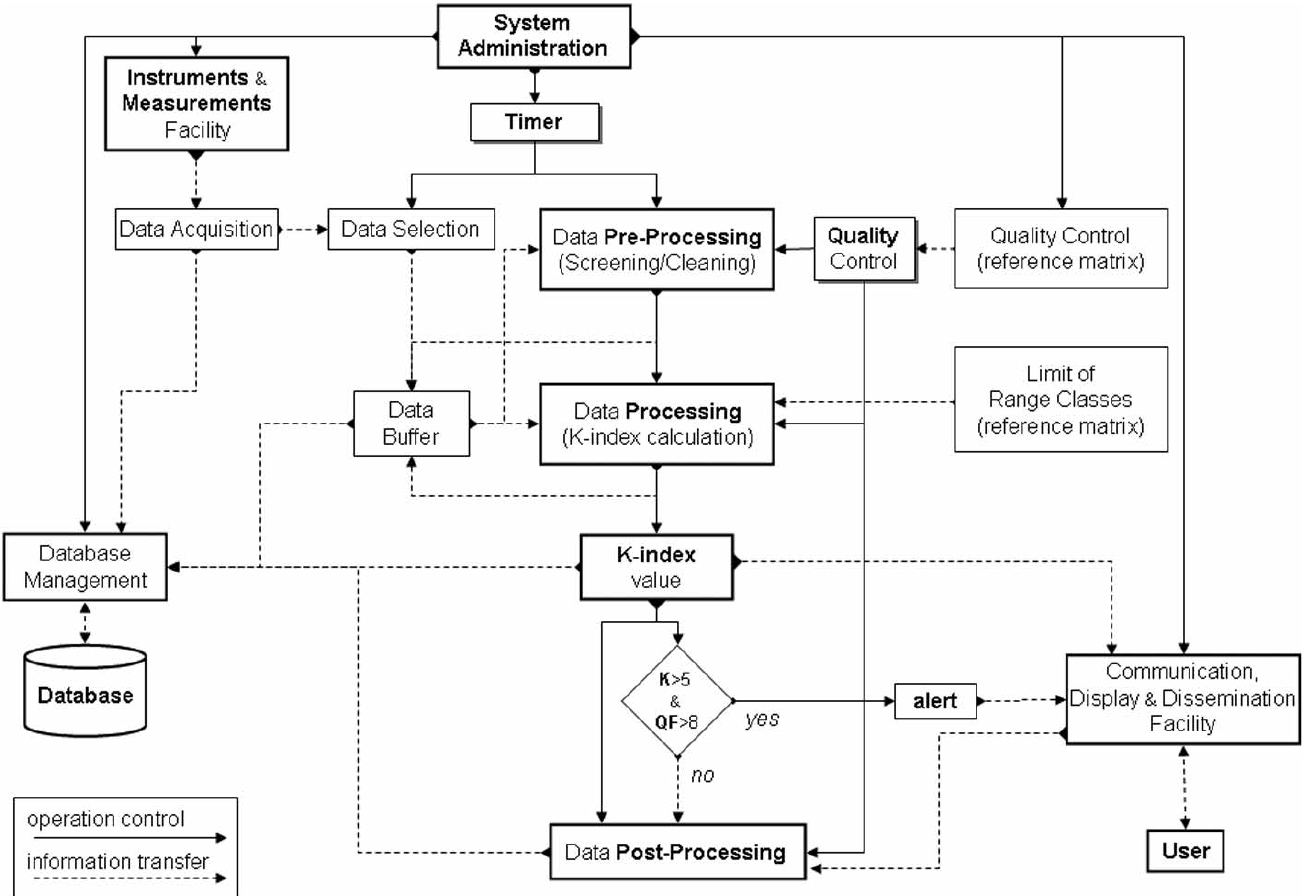
Figure 3. Flow chart of the K-index nowcast and alert